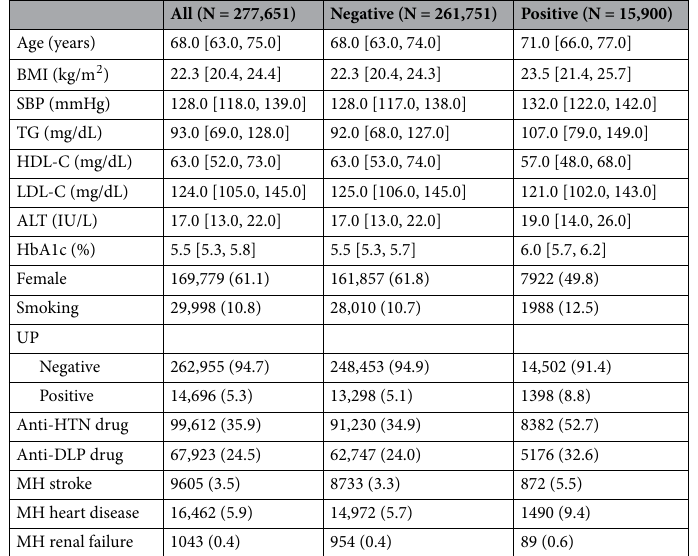
Table 1. Characteristics of variables for all subjects and those in the positive and negative groups. Values are presented as median [Q1, Q3] for continuous variables, and the number n and percentage in brackets